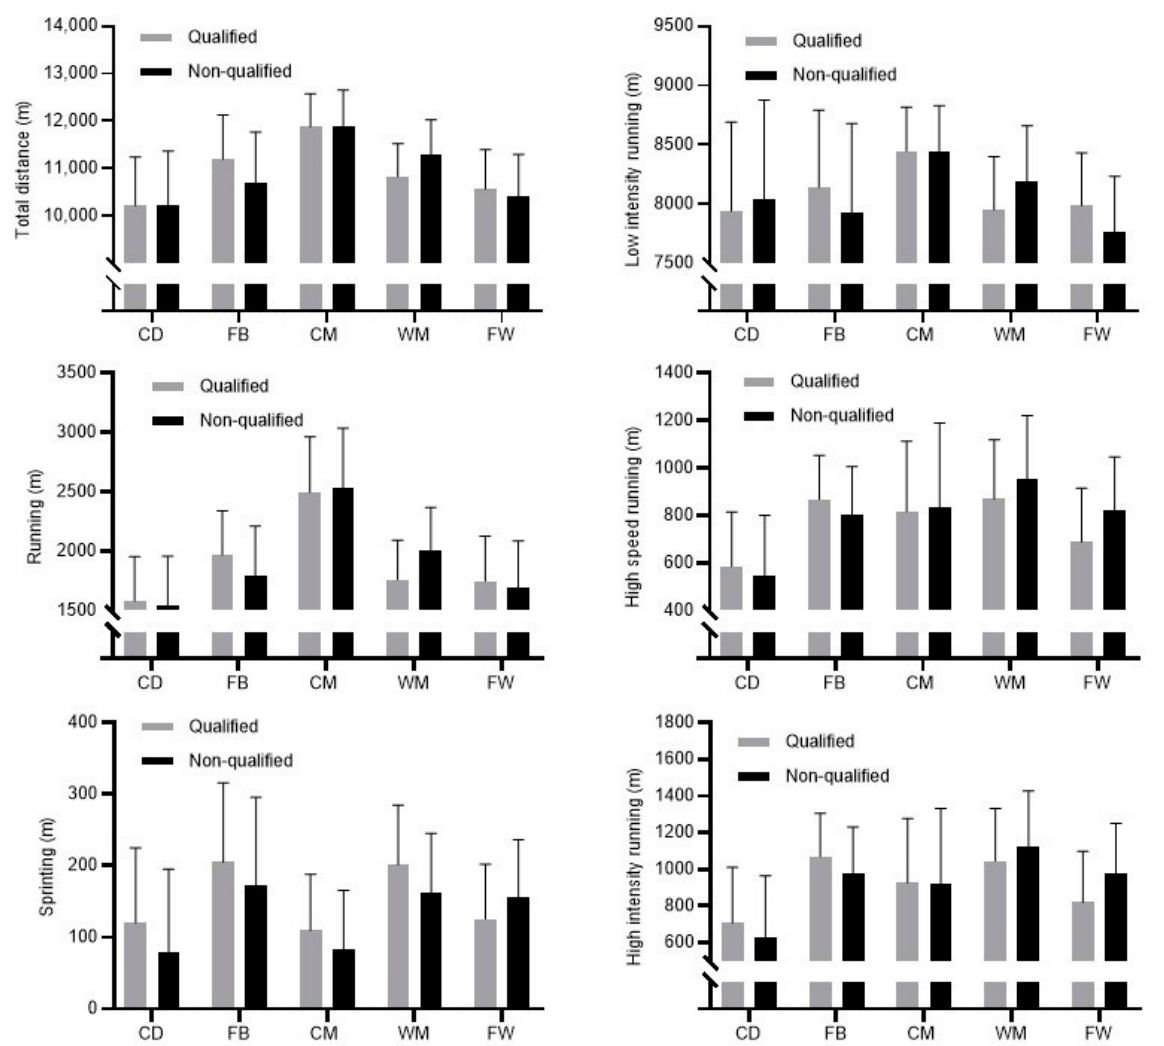
Figure 1. Descriptive statistics and differences in running performances for players at different playing positions (CD—central defenders, FB—full backs, CM—central midfielders, WM—wide midfielders, FW—forwards) according to their team’s qualification from the group stage of the UCL.